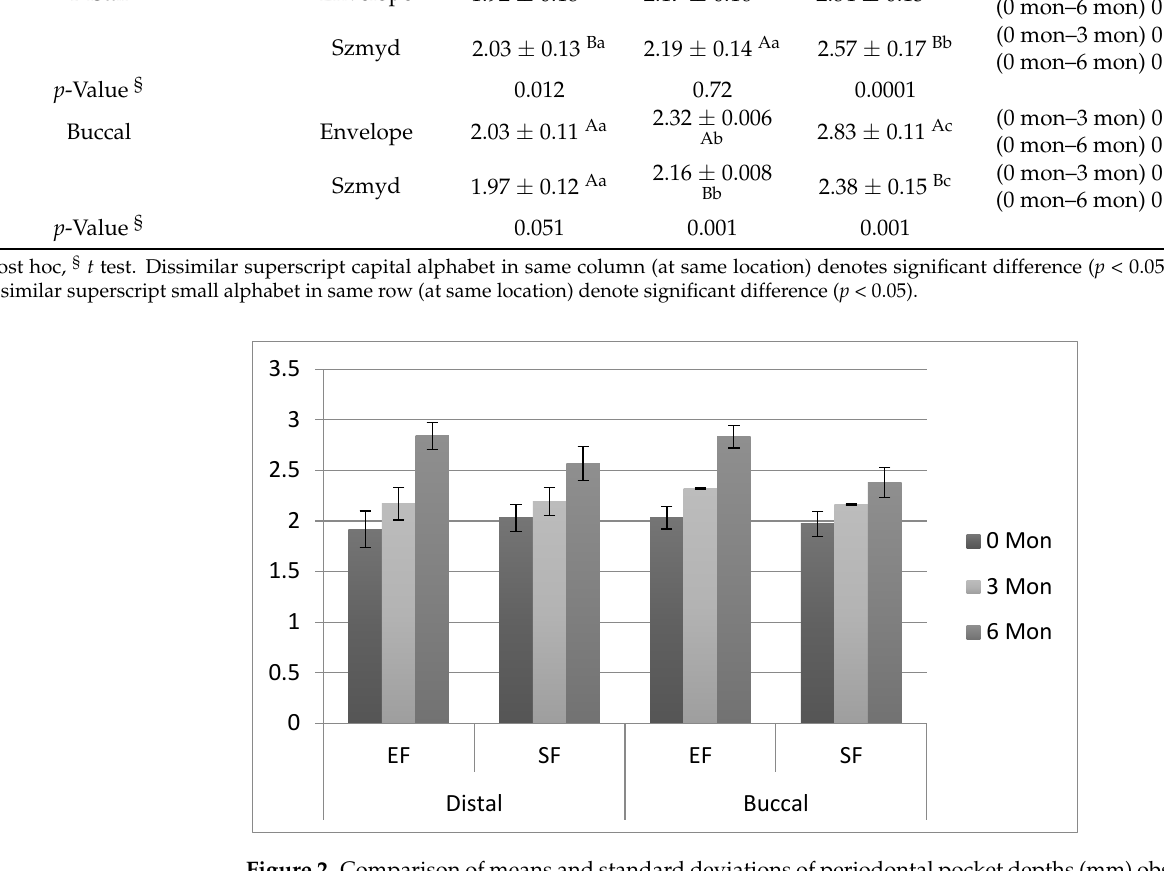
Table 4. Comparison of periodontal pocket depth (mm) around second molars included among study groups.